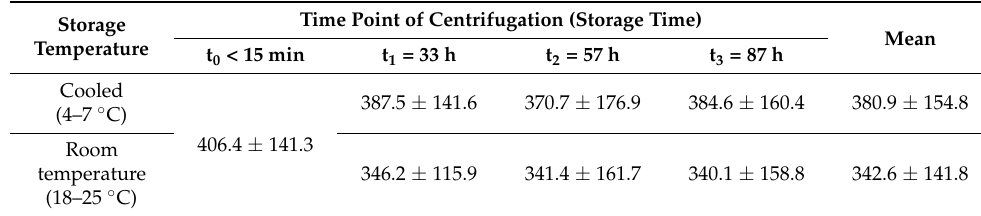
Table 1. Serum cortisol levels (mean ± standard deviation (nmol/L)) from wild boar ( n = 10) caught and killed in corral-style traps kept under different storage time and temperature (serum samples n = 70; each condition: n =